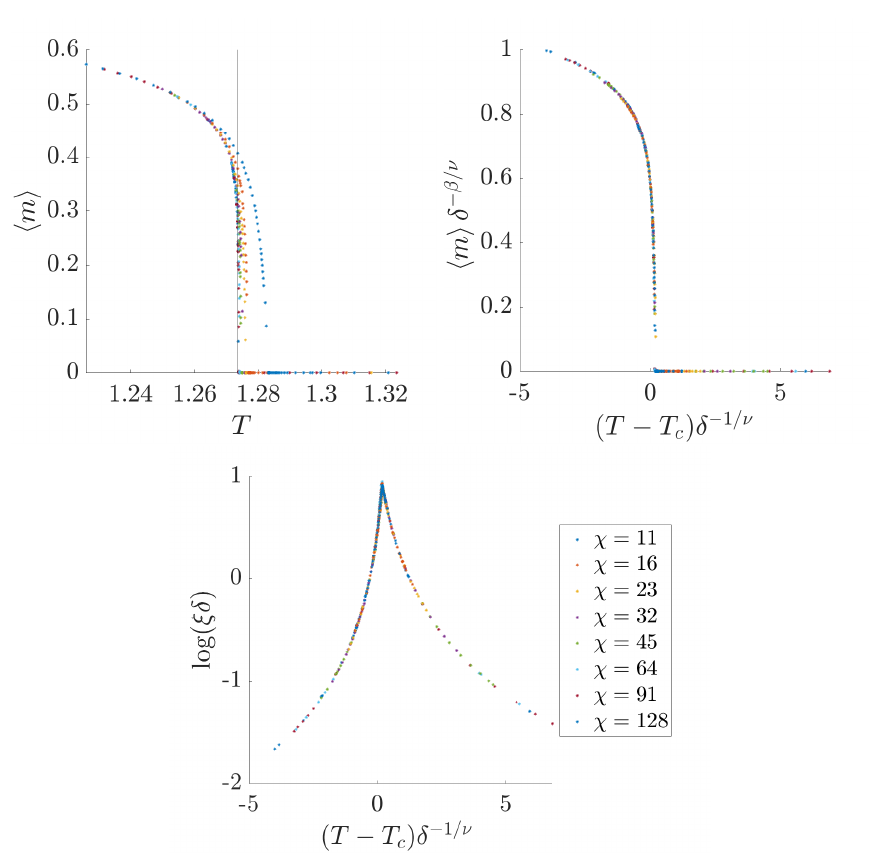
Figure 6: Results for 2-D transverse-field Ising model at g = 2.5, obtained by the VUMPS contraction of an order-six cluster TNO. The left panel shows a direct calcu- lation of the magnetization as a function of T for different values of χ . The middle panel shows the rescaled magnetization, according to the scaling hypothesis, where we have optimized T to yield the best collapse of the data. The right panel shows c the rescaled data for the correlation length extracted from the boundary MPS. The data set is sampled at values of χ = 11,16,23,32,45,64,91,128 with roughly 65 data points for each value of χ